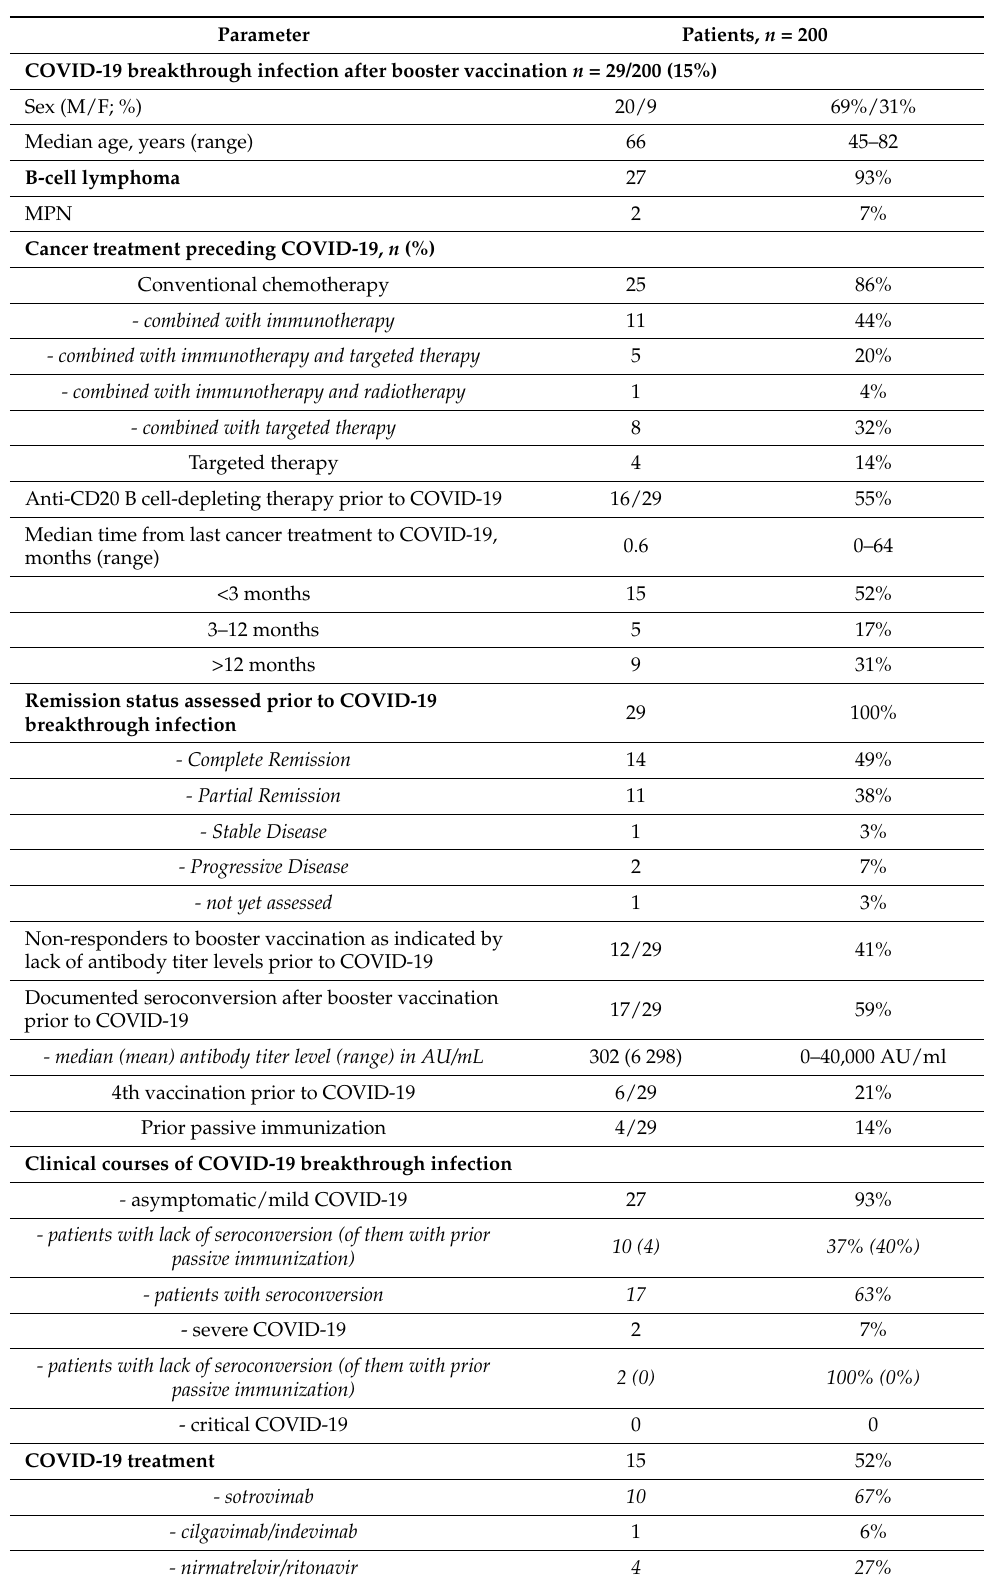
Table 4. COVID-19 courses in patients with hematologic neoplasms after prime-boost and partly second booster vaccination. Parameter Patients, n =